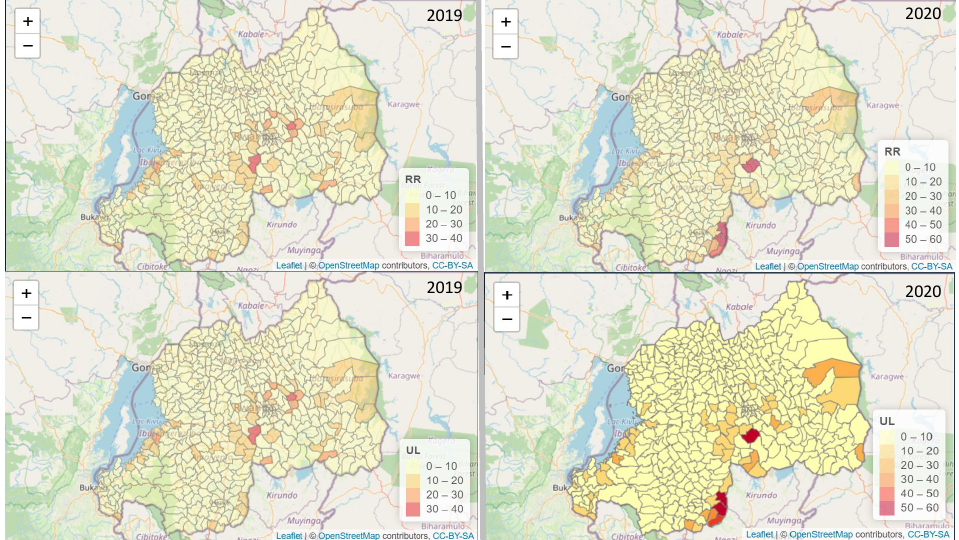
Figure 5. Spatial variation of malaria relative risk incidence among children under five years old in Rwanda (RR), posterior means of spatial effects with 95% upper limit (UL). Source: health facility routine data from 2019 and